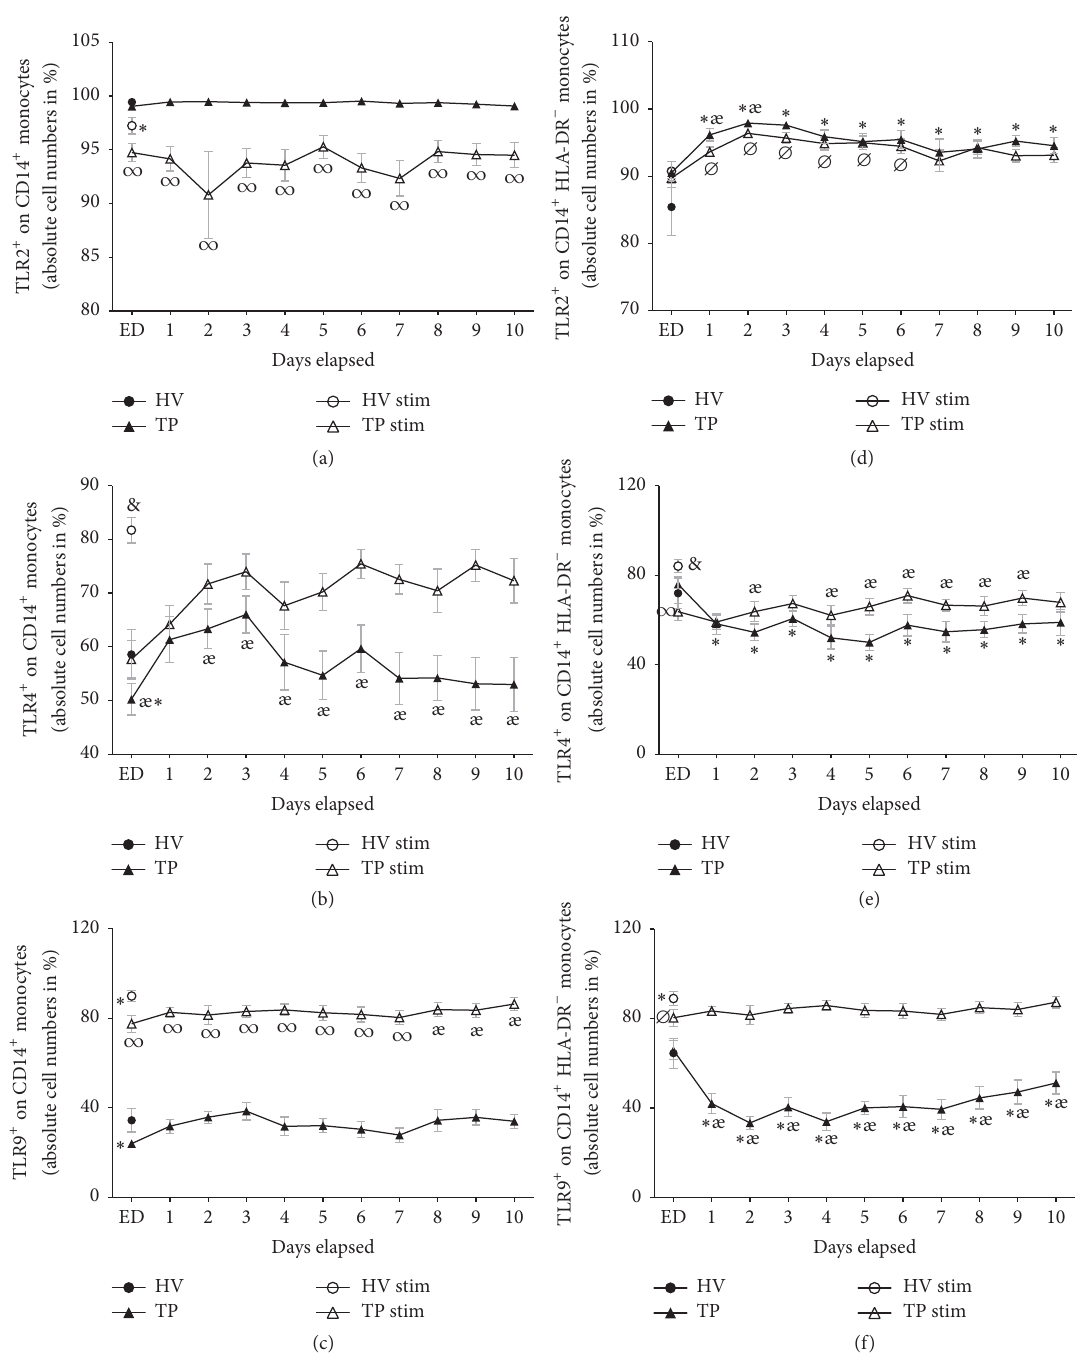
Figure 4: Whole blood from healthy volunteers (HV, 𝑛 = 14 ) or major trauma patients (TP, 𝑛 = 29 ) was analyzed over a 10-day time course after admission (emergency department, ED–10) by flow cytometry. Monocytes were detected using anti-human CD14 in the corresponding sidewardandforwardscatter.Unstimulated(blacksymbols)andstimulated(clearsymbols)measurementsweremade.Forstimulation(stim), whole blood was incubated with leukocyte activation cocktail for 5h with subsequent analyzing procedure as in unstimulated samples. Data are shown as mean ± SEM. (a) TLR2 expression in CD14 + monocytes, (b) TLR4 expression in CD14 + monocytes, (c) TLR9 expression in CD14 + monocytes, (d) TLR2 expression in CD14 + HLA-DR − monocytes, (e) TLR4 expression in CD14 + HLA-DR − monocytes, and (f) TLR9 expression in CD14 + HLA-DR − monocytes. ∗ 𝑝 < 0.05 versus unstimulated HV; ⌀ 𝑝 < 0.05 versus stimulated HV; æ 𝑝 < 0.05 TP versus corresponding TP stim; # 𝑝 < 0.05 HV ctrl versus all; & 𝑝 < 0.05 versus all; ∞ 𝑝 < 0.05 TP stim versus corresponding unstimulated TP and HV